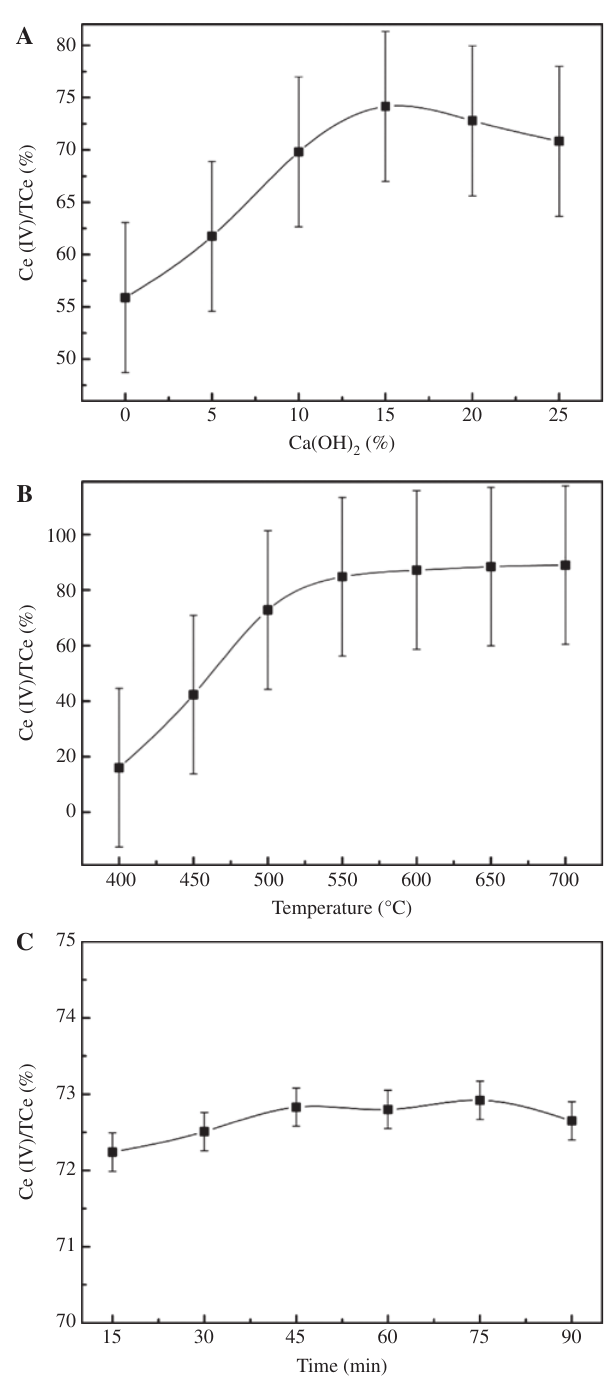
Figure 3: The influences of roasting conditions on bastnaesite decomposition.